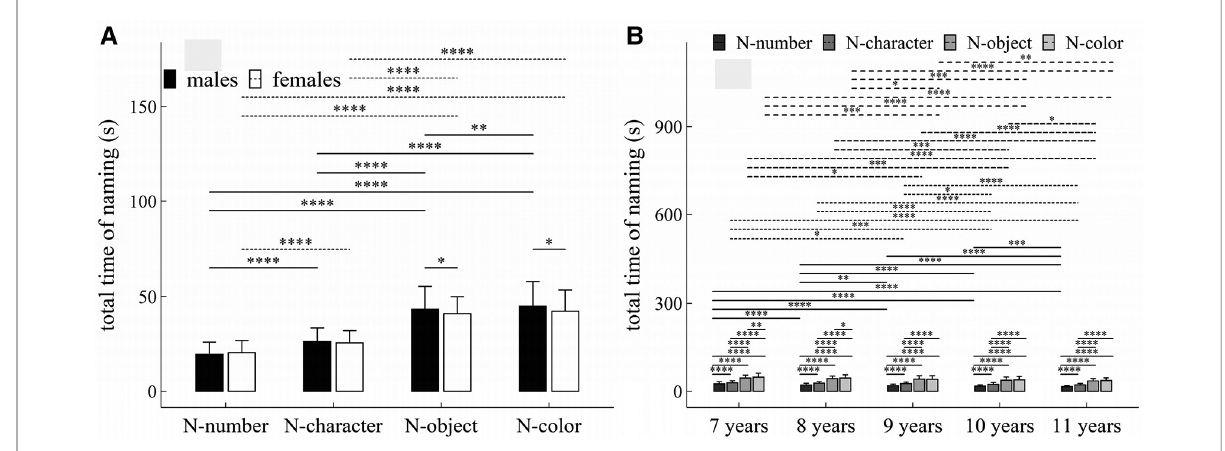
FIGURE 8 In fl uence of task-type, gender and age on total time of naming: ( A ) interactive effect of gender and task-type; ( B ) interactive effect of age and task- type. * p <0.05; ** p <0.01; *** p <0.001; **** p <1×10 − 4